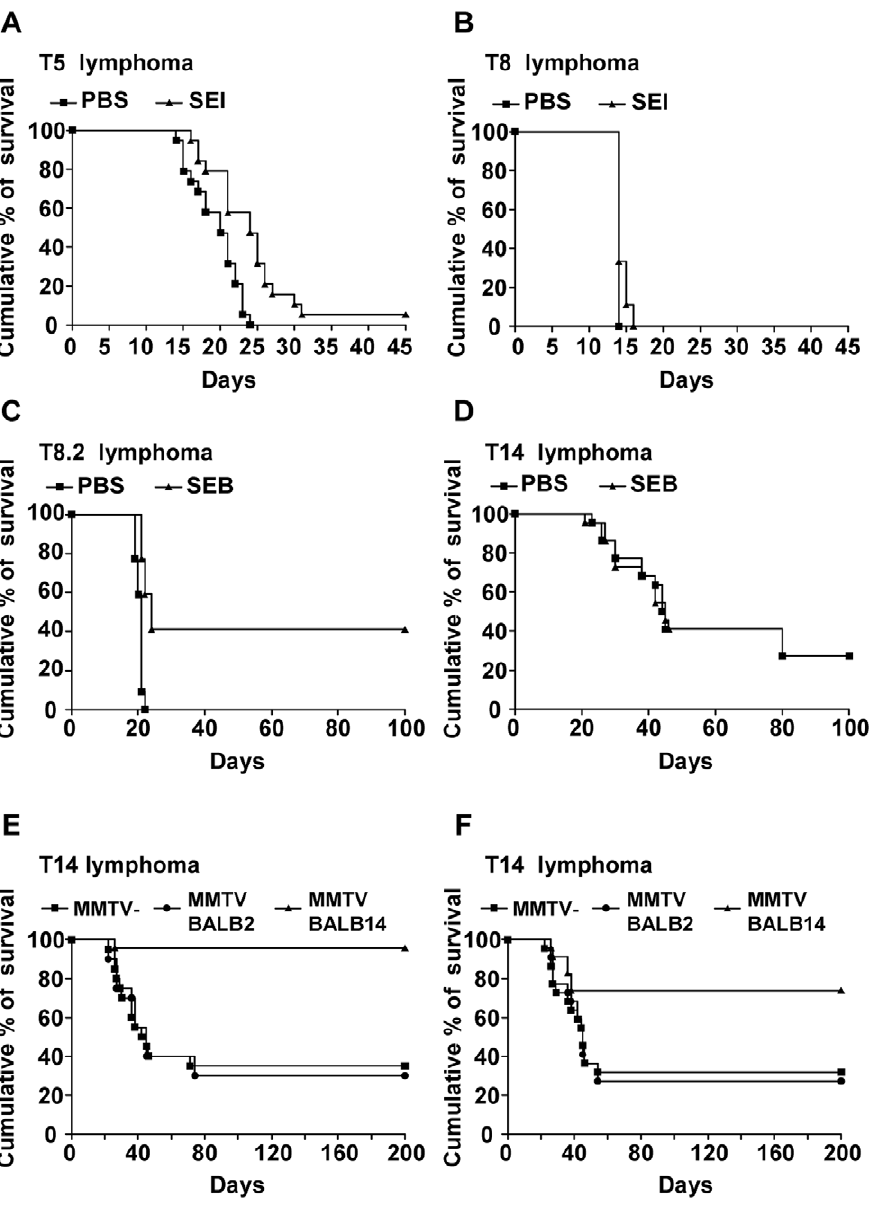
Figure 7. Sags increase the survival of cognate lymphoma-bearing mice. (A)T5 cells (5 6 10 3 ) or (B) T8 cells (5 6 10 3 ) were injected into the tail vein of AKR/J mice (n=19 per group). At days 2 and 3, mice received an intraperitoneal injection of 50 m g of SEI or PBS. p=0.0005, log-rank test. (C) T8.2 cells (1 6 10 3 ) or (D) T14 cells (1 6 10 3 ) were intravenously inoculated in AKR/J mice (n=22 per group). At days 2 and 3 mice were intraperitoneally inoculated with 50 m g of SEB or PBS. Control mice were treated with PBS. p , 0.0001, log-rank test. (E) T14 cells (1 6 10 3 ) were injected into the tail vein of MMTV BALB14-infected (n=22) and MMTV BALB2-infected (n=20) and non-infected (n=20) AKR/J mice. p , 0.0001, log-rank test. (F) T14 cells (1 6 10 3 ) were intravenously injected in AKR/J mice. Two days later, mice were infected as described in Materials and Methods with MMTV BALB14 (n=22) or MMTV BALB2 (n=22). Control mice received PBS (n=22). p=0.0123, MMTV- vs MMTV BALB14; p=0.0075, MMTV BALB2 vs MMTV BALB14, log-rank